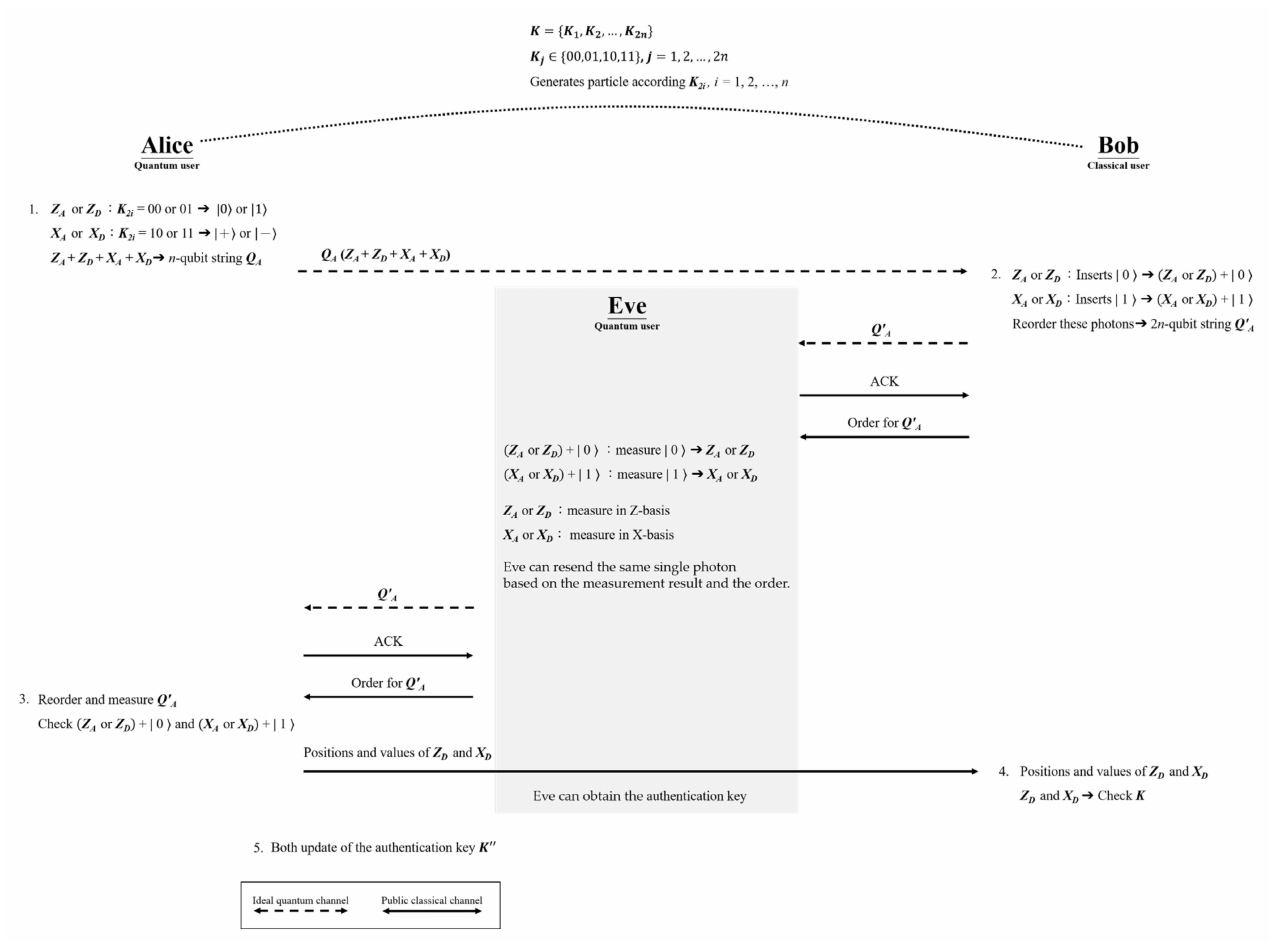
Figure 4. The man-in-the-middle attack on Zhou et al.’s measurement-free SQA